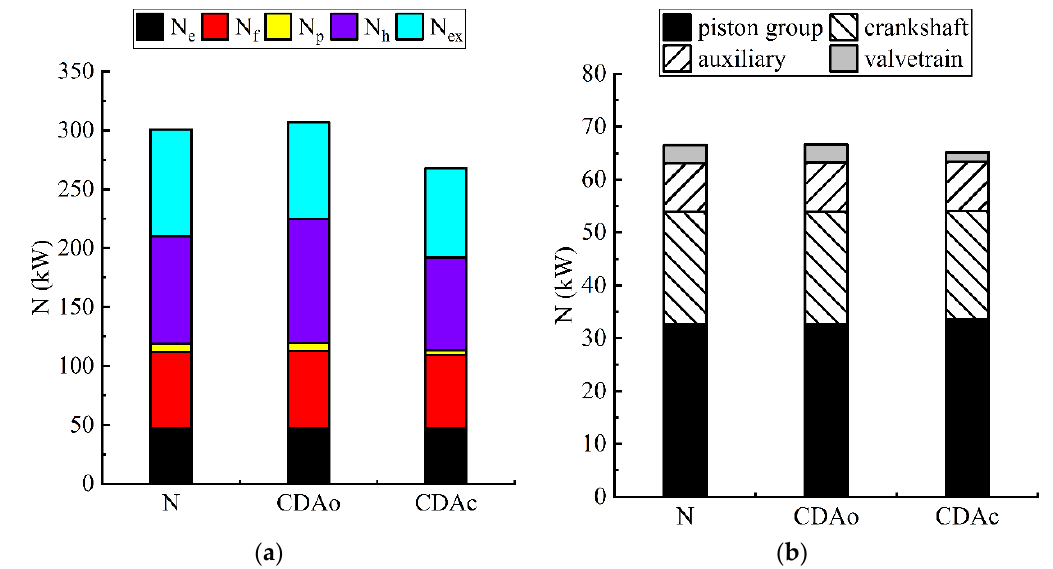
Figure 11. The distribution of fuel combustion energy for the engine ( a ) and mechanical loss components of the engine ( b ) under the normal mode and CDA modes at an engine speed of 450 rpm and an engine load of 1000 N ∙ m (the calculated results were obtained from 1D simulation of GT-SUITE).